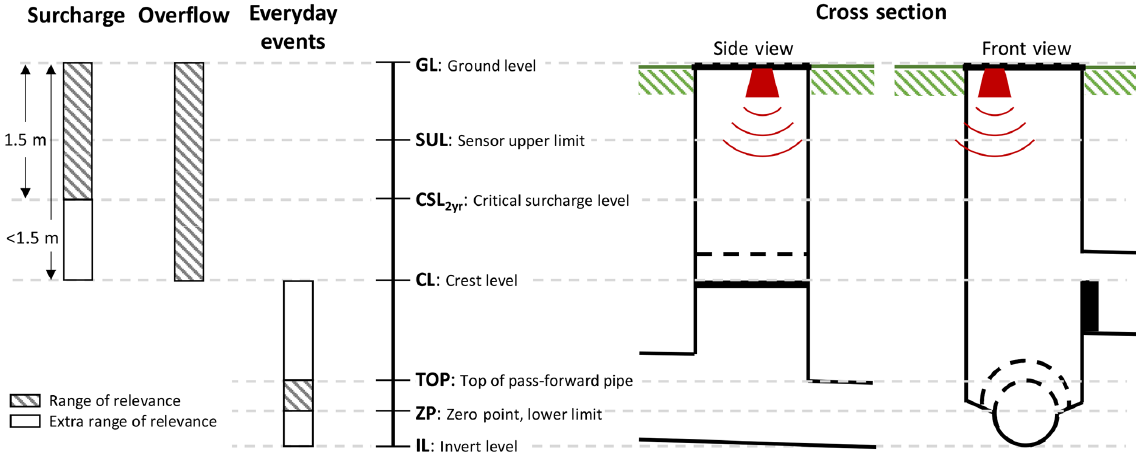
Figure 3. Illustration of the three model objectives (surcharge, overflow, and everyday events) in relation to water levels in the system (left), explanations of the symbols used for specific water levels in the figure (middle), and cross sections through a structure equipped with an overflow weir (right). Overflow occurs for events where the water level rises above the crest level (CL). Surcharge occurs for events where the water level rises above the critical surcharge level (CSL), which is defined as 1.5m below ground level (GL) – or if the crest level (CL) or the top of pipe (TOP) is within the range of 1.5m, then that level will be the CSL. Everyday events are when the water levels being observed or modelled are below the top of the pipe (or CL if this level is lower) and above the invert level (IL, or zero point, ZP, i.e. a lower sensor limit if this level is higher).